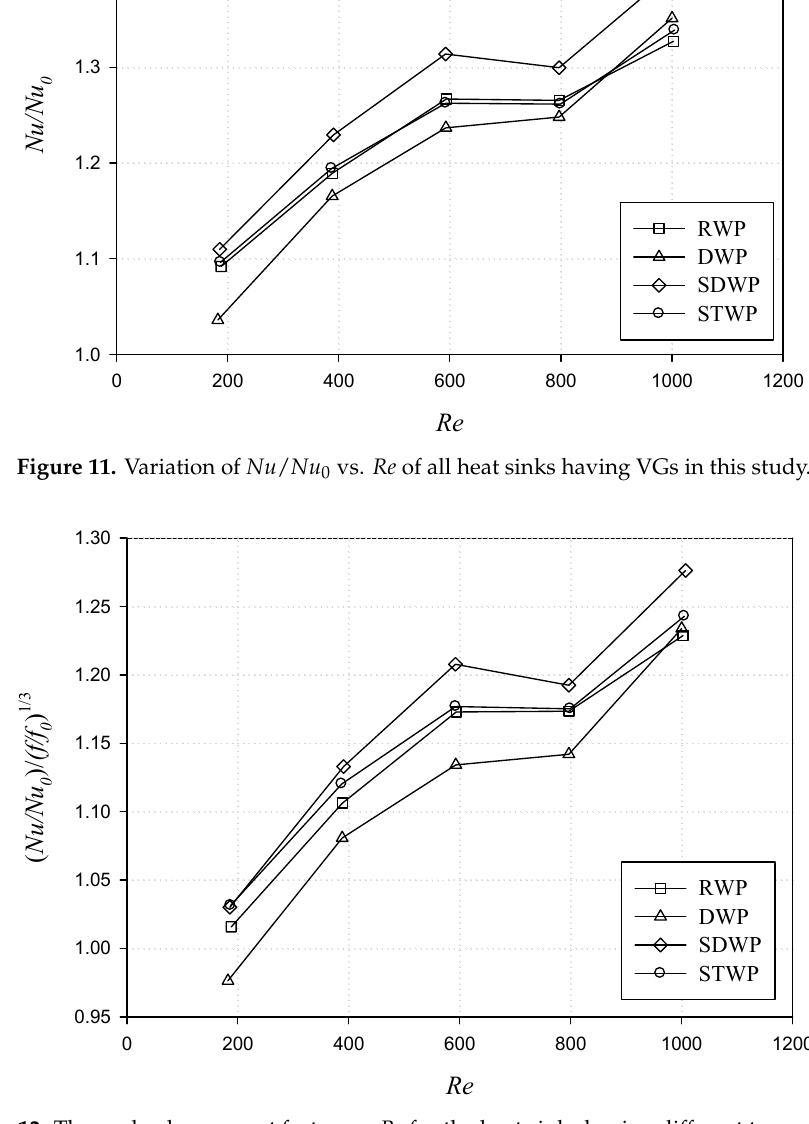
Figure 12. Thermal enhancement factor vs. Re for the heat sinks having different types of VGs.